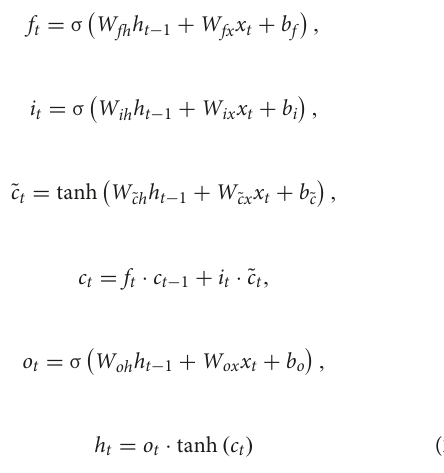
FIGURE8 Pseudo-color image of a penicilliosis navel orange